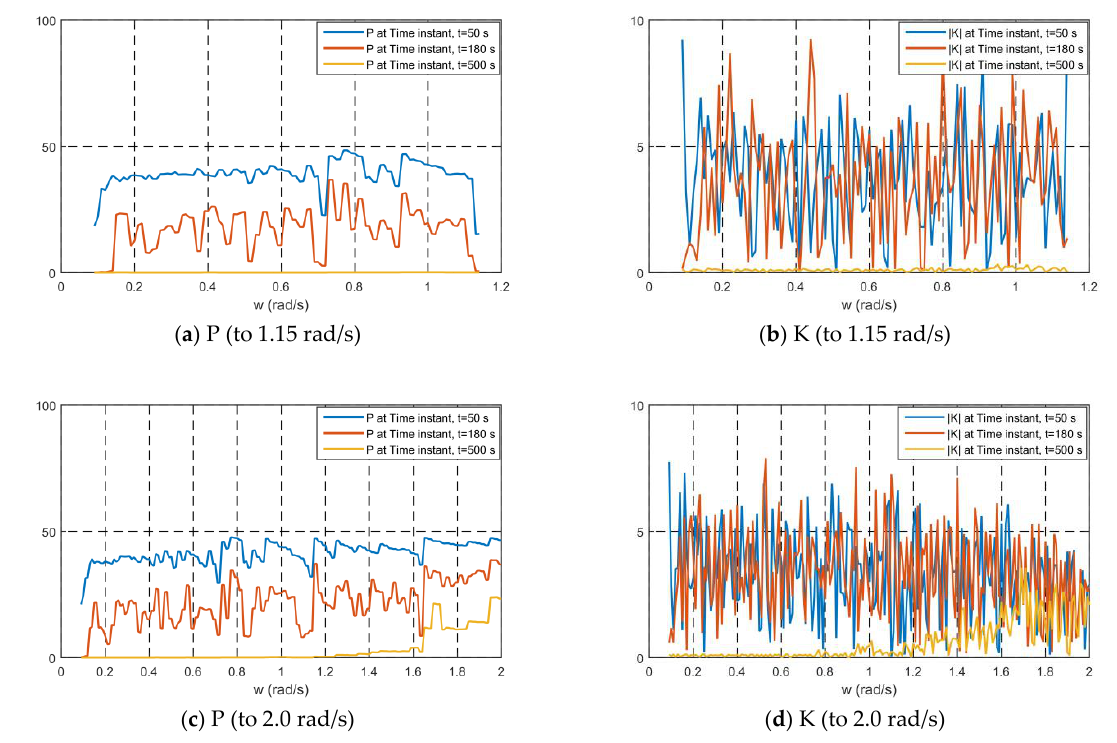
Figure 9. Comparison of error covariance and Kalman gain for frequency extension. ( a ) P (to 1.15 rad/s); ( b ) K (to 1.15 rad/s); ( c ) P (to 2.0 rad/s); ( d ) K (to 2.0 rad/s).